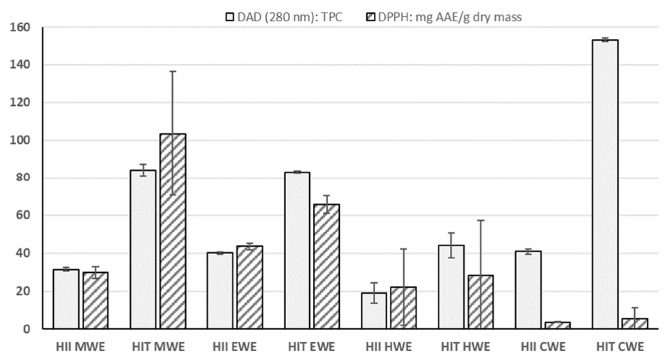
Figure 3. Representation of DPPH results in comparison with TPC. MWE—methanol:water extract, EWE—ethanol:water extract, HWE—hot water extract and CWE—cold water extract.